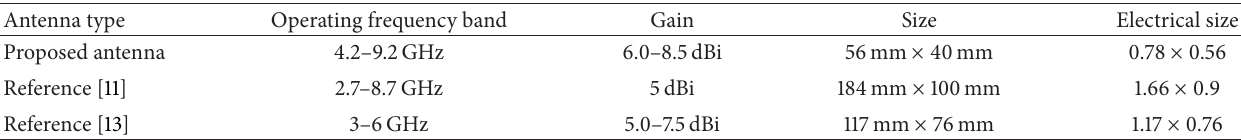
Table 2: Comparison between the proposed antennas and the ones in